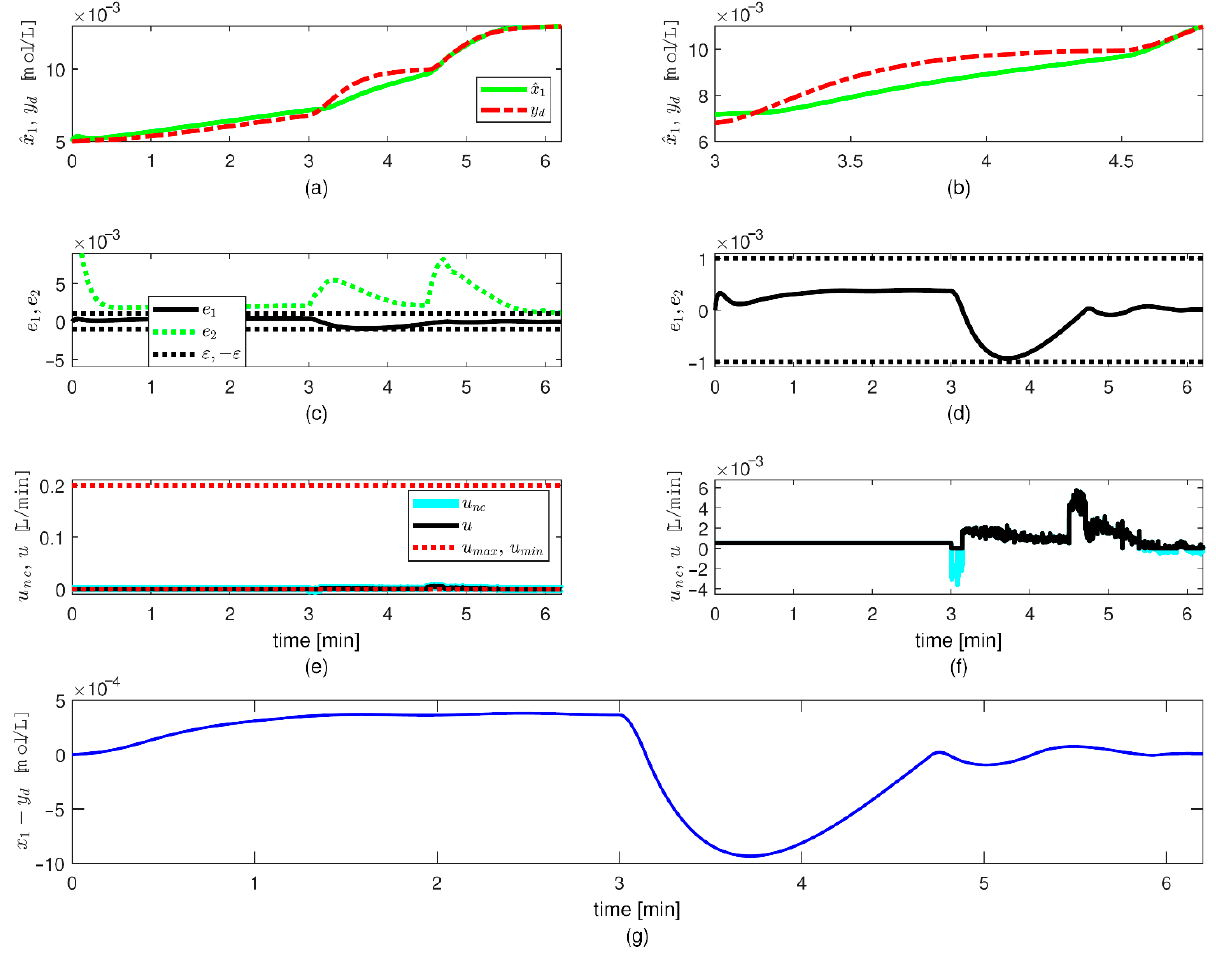
Figure 3. Controller simulations for the first case. ( a ) Time course of the estimated state ˆ x 1 and desired tracking trajectory y d . ( b ) Detail of time course of ˆ x 1 and y d . ( c ) Time course of the tracking error e 1 = ˆ x 1 − y d and e 2 = ˆ x 2 − x 2 d . ( d ) Detail of time course of e 1 , e 2 . ( e ) Time course of the unsaturated and saturated signals u nc , u . ( f ) Detail of time course of signals u nc , u . ( g ) Time course of x 1 − y d